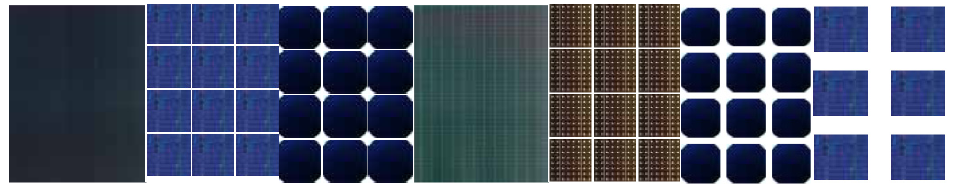
Figure 6. Example of solar cell glazing products from Sapa Building System [26] using either